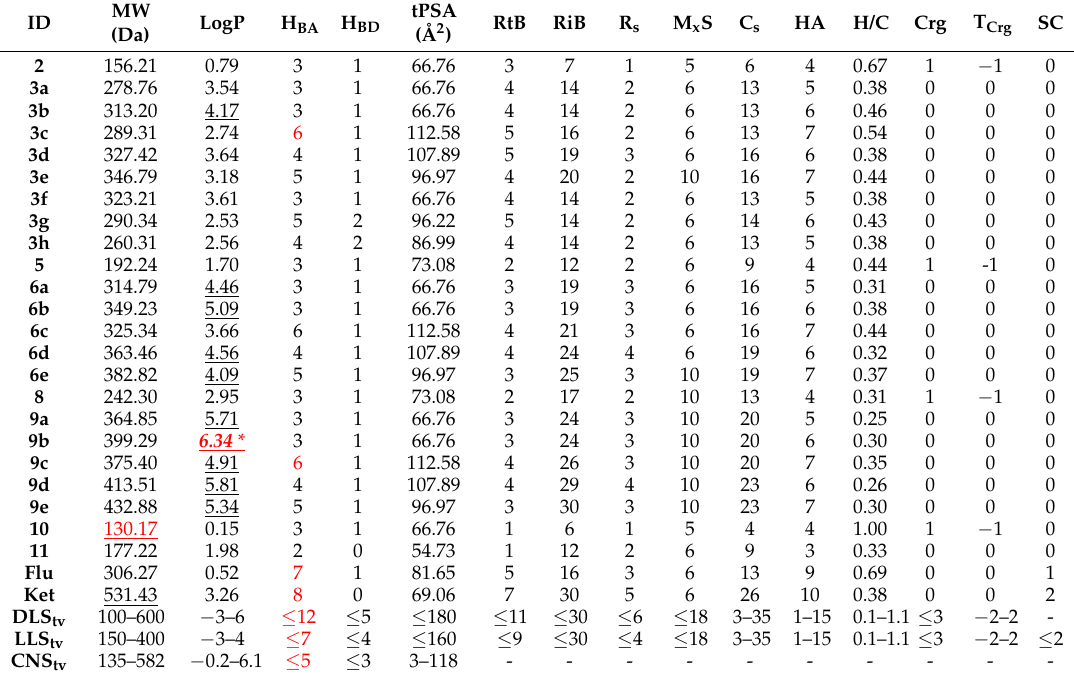
Table 6. The results of VS carried out for lead-like and drug-like